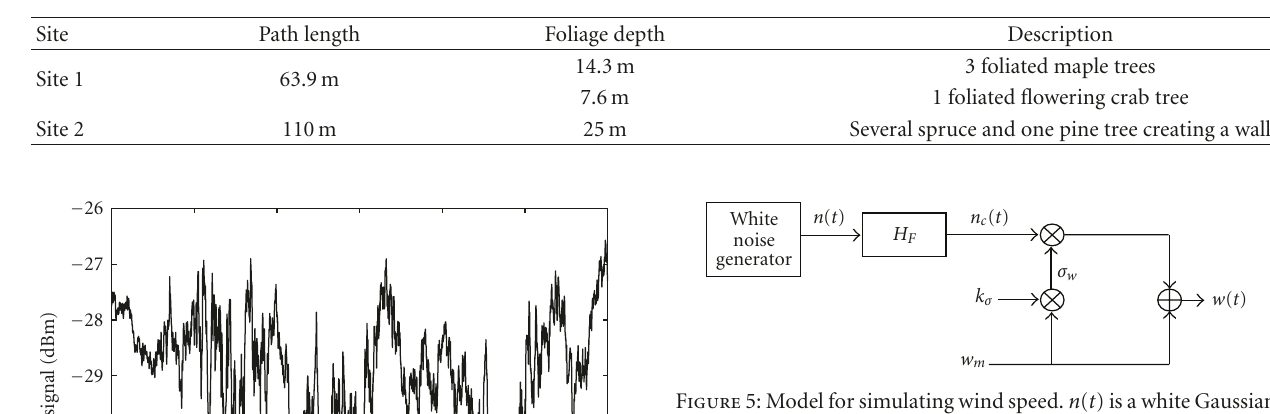
Table 1: Site description [7].